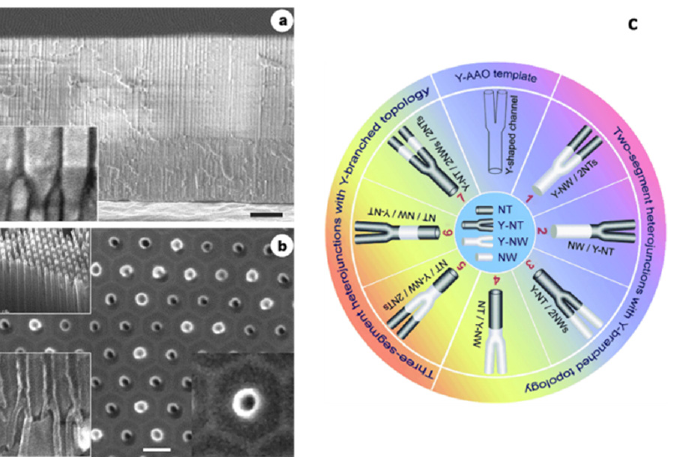
Figure 16. ( a ) SEM cross-section of a Y-branched template obtained by reducing the anodization by a factor 1 / √2 .( b ) SEM images of the branched PAA template after CNTs synthesis using electrodeposited Co catalyst. ( c ) Catalogue of CNT/NW and NT/NW/NT hybrid nano-architectures. CNTs (hollow) are represented in black and NWs (solid) in white; Y-NT and Y-NW indicate Y-shaped NTs and NWs. Reprinted with permission from Ref. [194]. Copyright © 2023 WILEY-VCH Verlag GmbH & Co. KGaA, Weinheim.